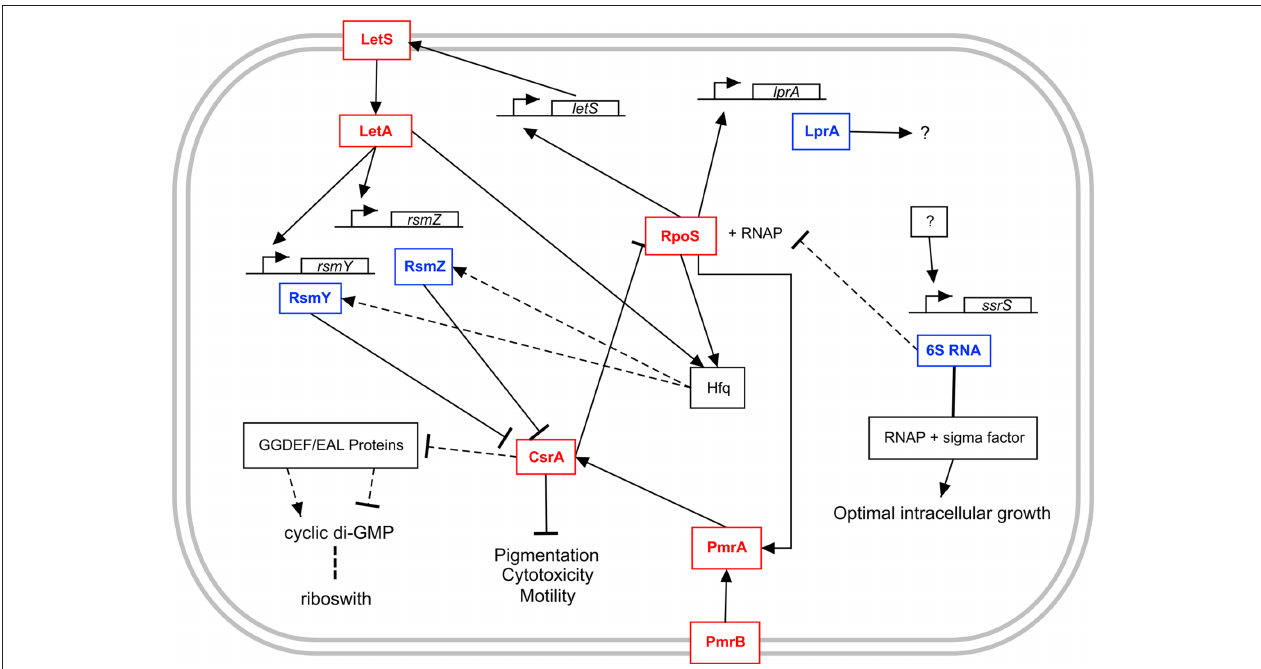
FIGuRe 3 | Model of the regulatory networks involving sRNAs in L. pneumophila . The lines show interaction between the players: Arrow, activation; T bar, repression; dotted line, putative, or predicted interaction. See text